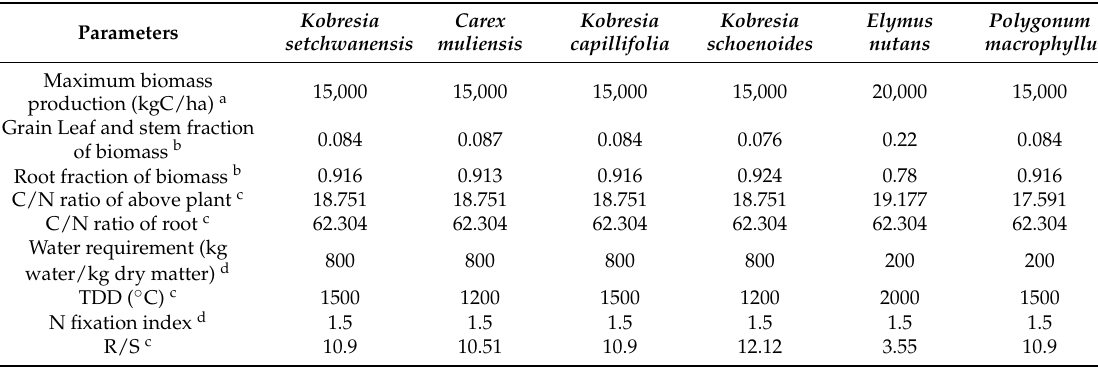
Table 3. Values of input vegetation parameters used in the DNDC